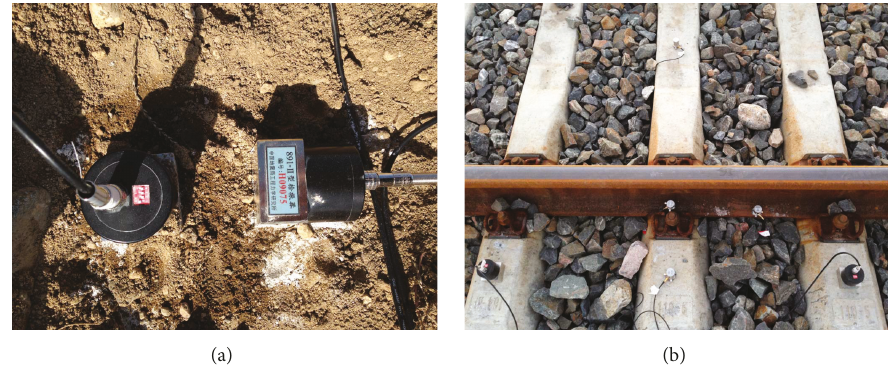
Figure 1: Types of accelerometers used in the test: (a) 891-2 and (b) BZ1191.